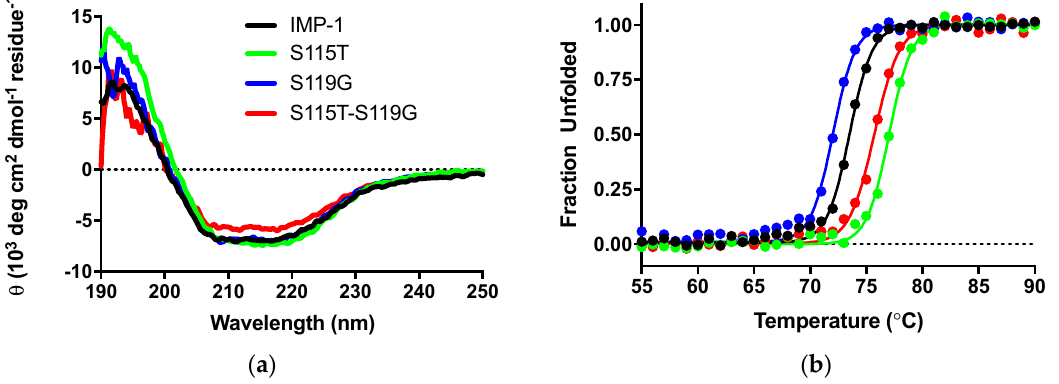
Figure 4. ( a ) CD scans of the four enzymes indicating that the secondary structures are comparable. θ indicates ellipticity. ( b ) Thermal denaturation monitored by CD at 215 nm.